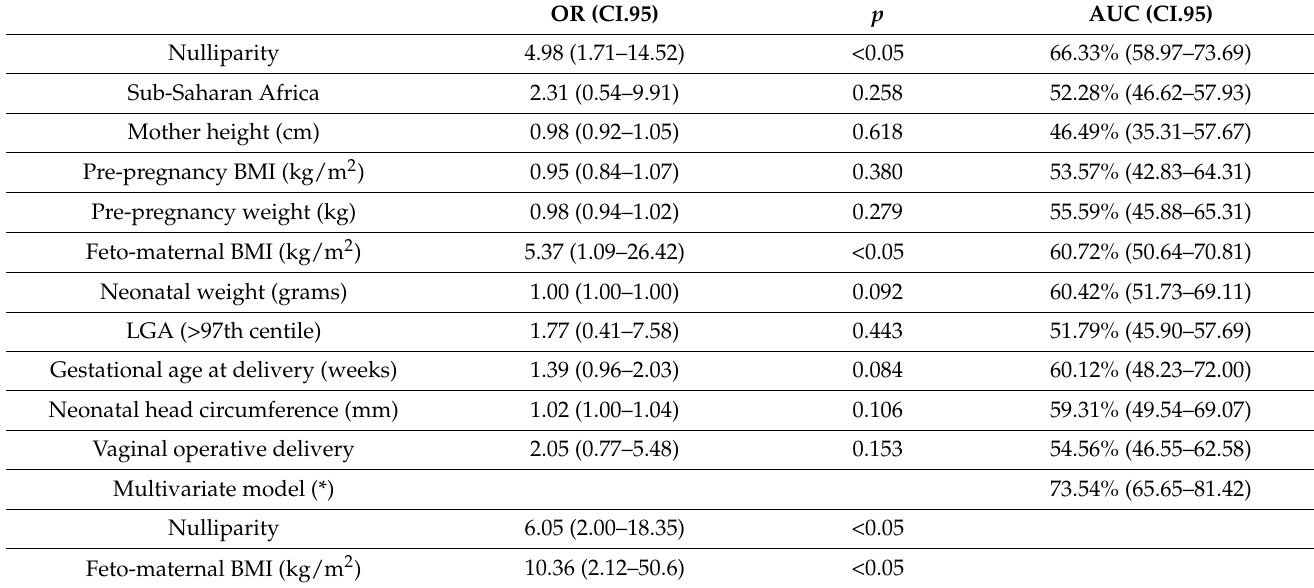
Table 3. Analysis by logistic regression, dependent variable presence of grade 3–4 perineal tears.